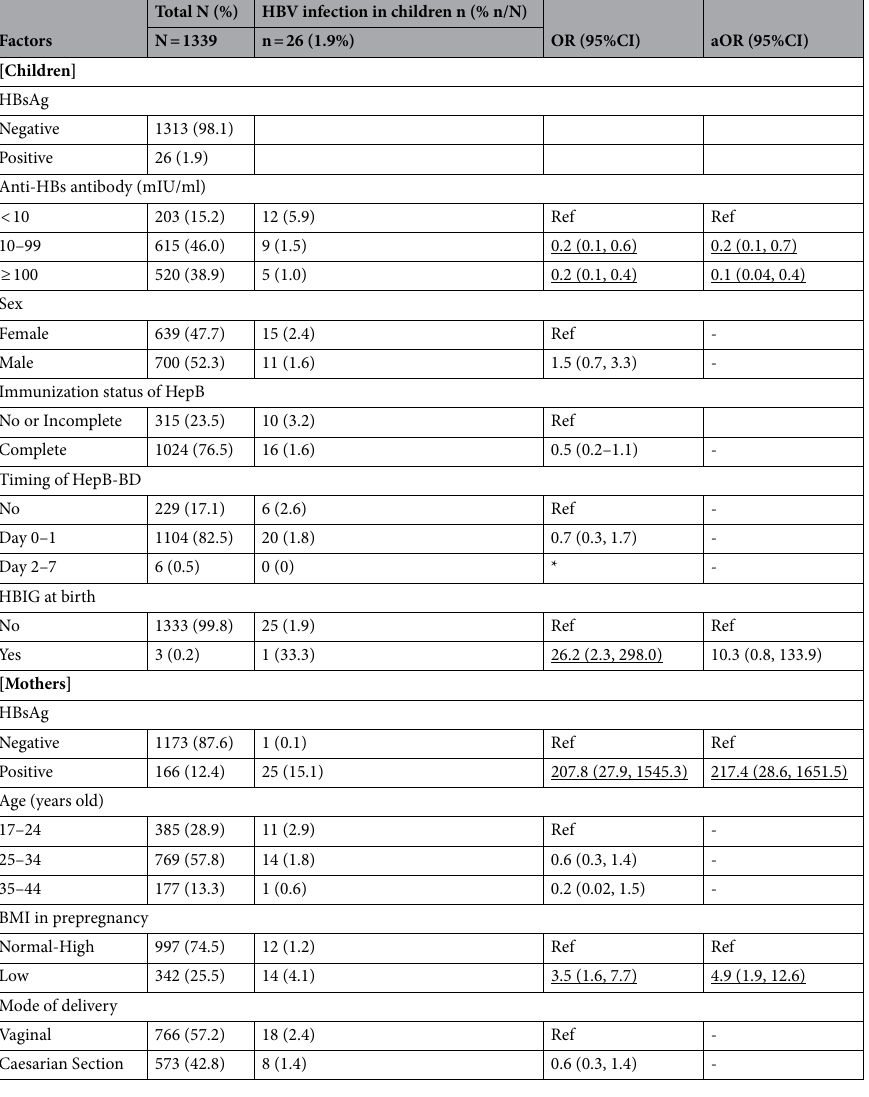
(OR) in univariate analysis and adjusted odds ratios (aOR) in multivariate analysis. Variables with statistical significance were underlined where 95%CI of aOR did not include 1. HBsAg: hepatitis B surface antigen; HBV: hepatitis B virus; anti-HBs antibody: anti-hepatitis B surface antibody; N: number; OR: odds ratio; CI: confidence interval; aOR: adjusted odds ratio; HepB: hepatitis B vaccine; HepB-BD: birth dose of HepB; incl.; including; w/o: without; HBIG: hepatitis B immune globulin; BMI: body mass index; and Ref.: reference. *Dropped since no HBsAg-positive cases existed in the